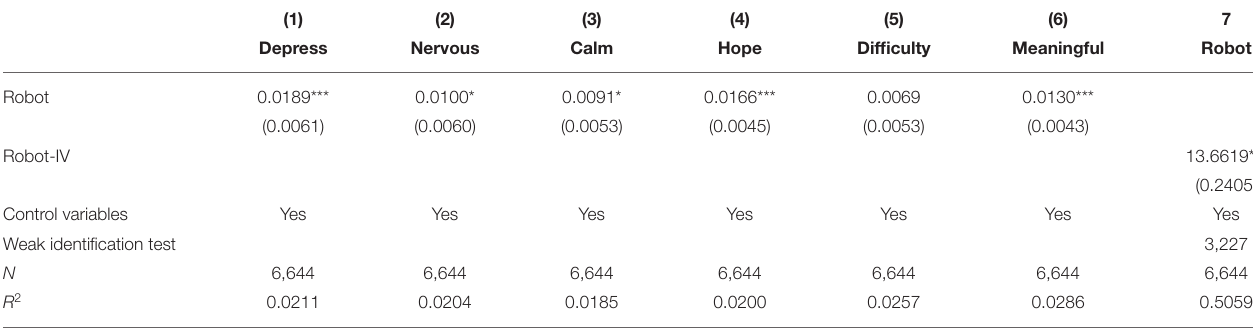
TABLE 3 | Instrumental variable estimation.